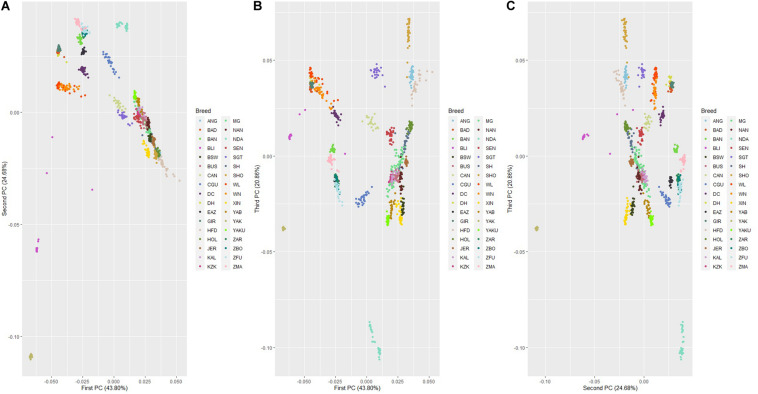
Principal component decomposition of the genomic relationship matrix colored by population*. Letters in the figure represent the decomposition of the: (A) first and second; (B) first and third; and (C) second and third principal components, respectively (*see Supplementary Table 1 for abbreviations).